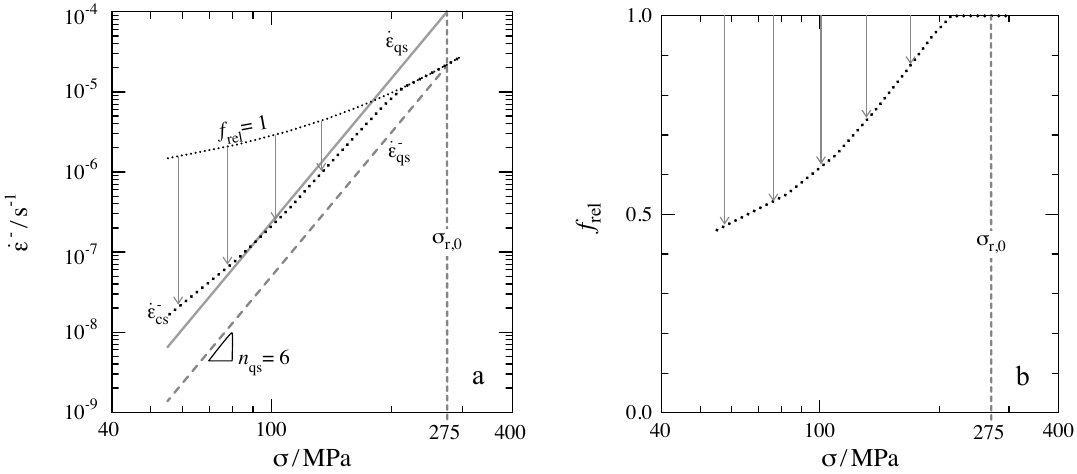
Figure 7. ( a ) Recovery–strain rate ˙ (cid:101) − cs at constant structure after R -change from Figure 6b (black dotted) compared to qs strain rate ˙ (cid:101) qs (grey solid) and recovery–strain rate ˙ (cid:101) − qs in the qs state (grey dashed), ( b ) anelastic relaxation factor f rel as function of σ ≈ R σ r,0 required to model ˙ (cid:101) − cs from ( a ) with Equation